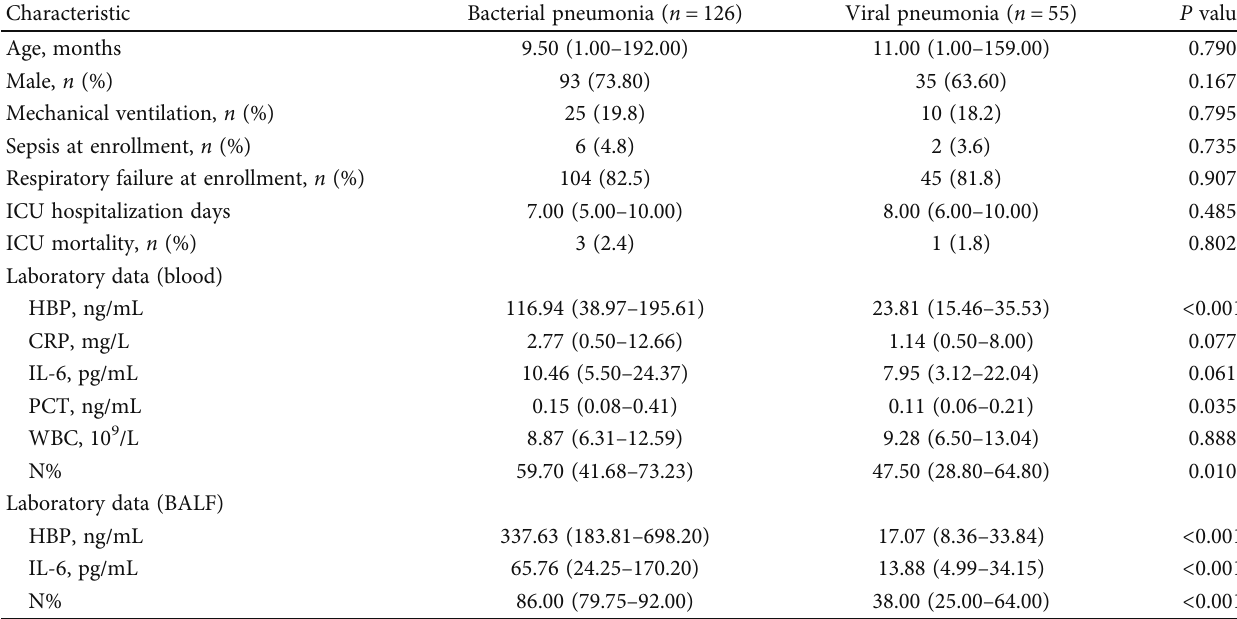
Table 1: Characteristics of the study population.